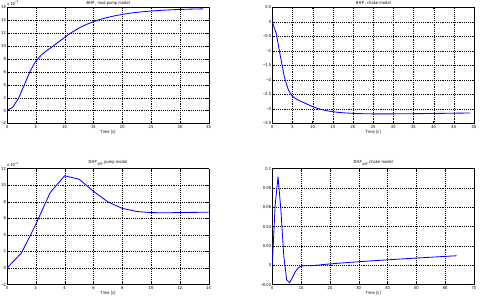
Figure 5: Bottom hole pressure. The error is within 0.4 bars.